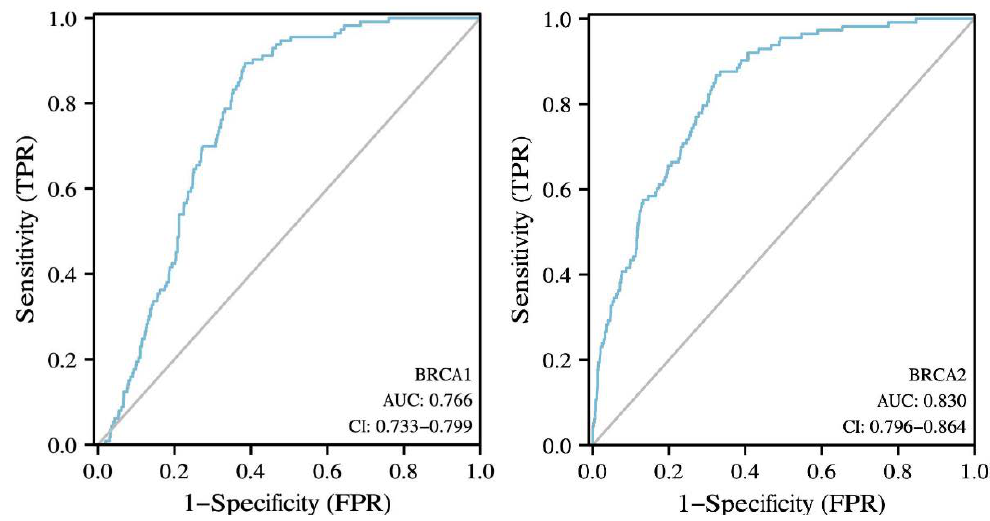
Figure 3. The diagnostic value of BRCA1/2 in BRCA patients. The diagnostic value of BRCA1/2 in BRCA patients. AUC: area under curve.